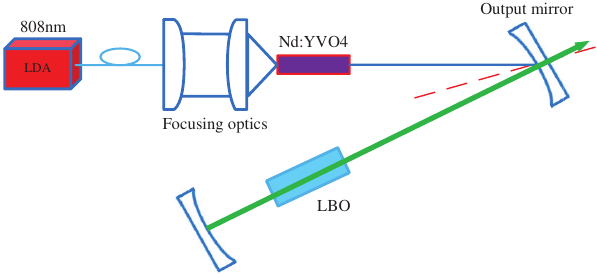
Fig. 2. Design scheme of the internal frequency-doubled fol- ded cavity 200 (cid:2) m, and the numerical aperture is 0.22. The module has red light indication, optical power